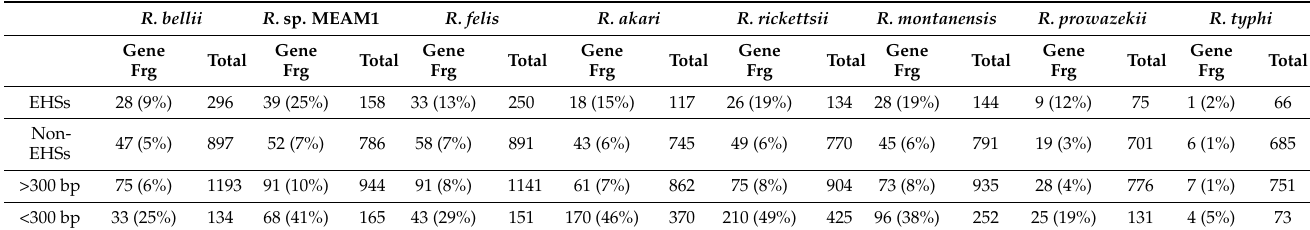
Table 2. Gene Fragment Concentration in Different